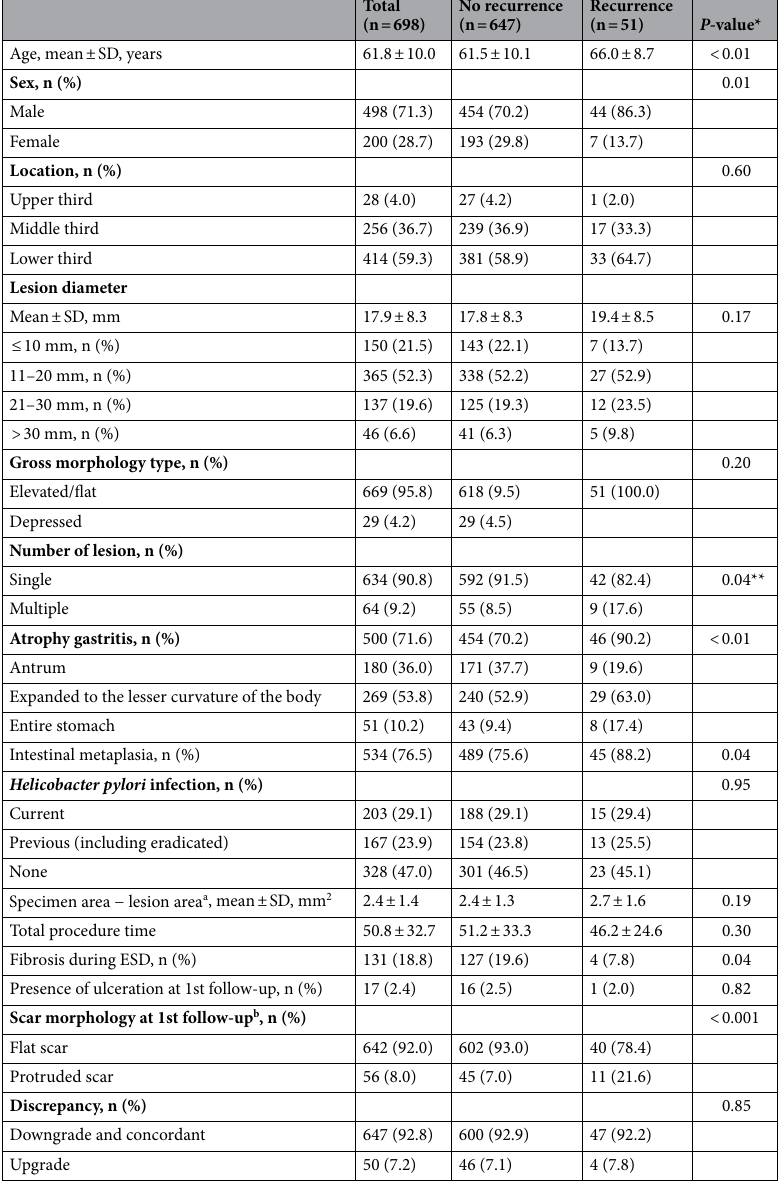
Table 1. Baseline characteristics of enrolled patients after endoscopic submucosal dissection with curative resection. ESD, endoscopic submucosal dissection; n, number; NA, not applicable; SD, standard deviation. *Non-recurrence vs. recurrence. **Fisher’s exact test was applied. a (Area of the specimen − area of the lesion)/1000. b If ulceration was observed at the first follow-up, scar morphology was evaluated according